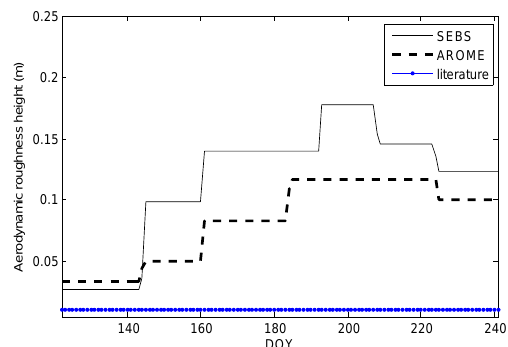
Fig. 1. Bias in aerodynamic roughness height estimation over short grassland around BJ station during experimental period of this study: original SEBS model, literature (Beljaars et al., 1983) and AROME model (MODIS